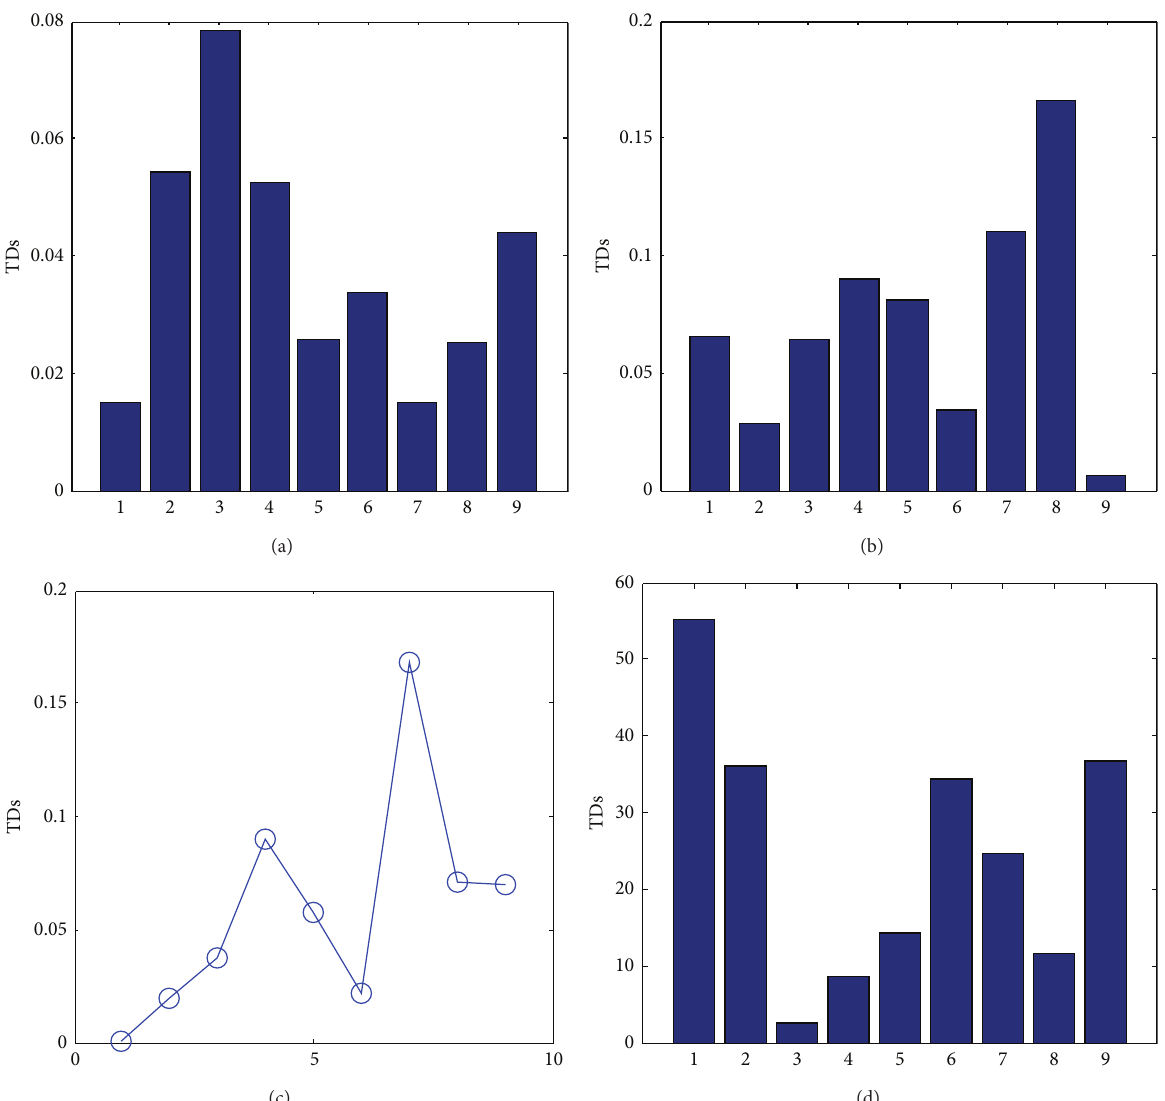
Figure 15: Detection indicators of the cantilever beam when 𝛾 = 0 . 2 for frequency band of 0–50 Hz with 20 dB: (a) this paper, (b) Schulz et al. [4], (c) magnitude value of Zhang et al. [6], and (d) Johnson and Adams